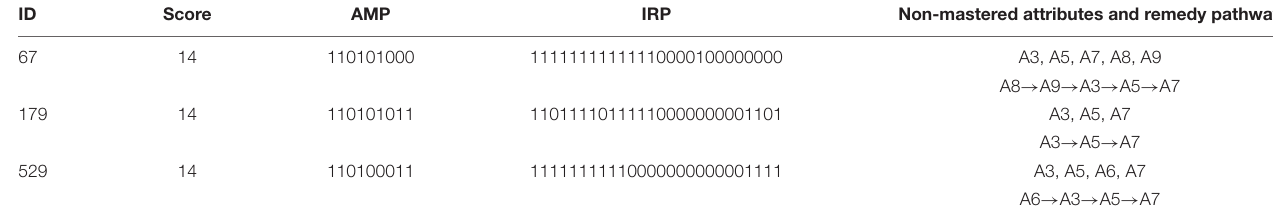
TABLE 7 | Individual information of three